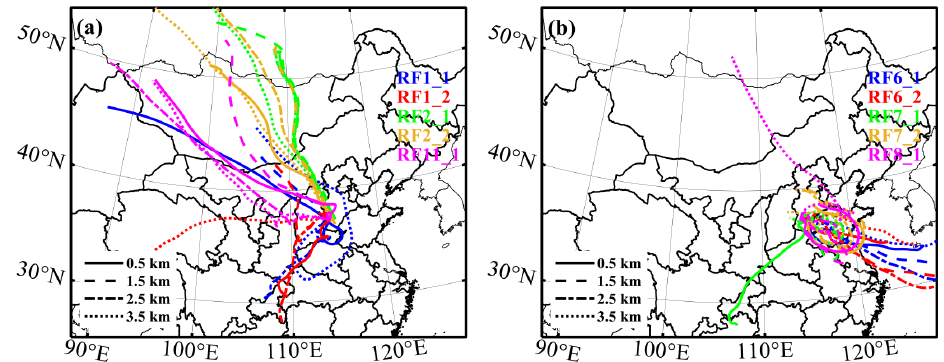
Figure 2. 72-hour HYSPLIT back trajectories over the sampling region: (a) northwesterly air masses and (b) southeasterly air masses. The color of trajectories indicates different flight codes associated with N CCN profiles. The line type shows trajectories with different starting altitudes (0.5, 1.5, 2.5, and